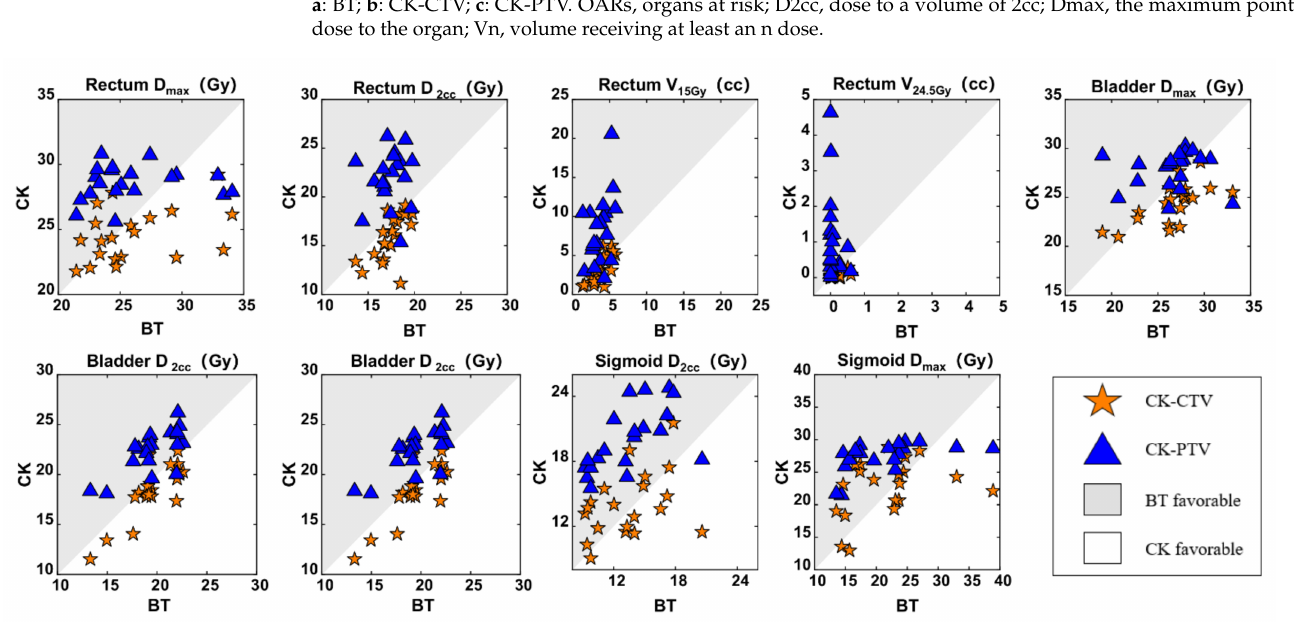
Figure 3. Comparisons of the BT, CK-CTV, and CK-PTV plans by the dosimetric parameters in relation to the OARs. For every patient, each parameter is associated with three values (from the BT plan, CK-CTV plan and CK-PTV plan). In each graph, for the parameter X, each patient will contribute a pair of symbols, i.e., a star and a triangle; the star is plotted by the coordinates X BT , X CK-CTV , while the triangle is plotted by X BT , X CK-PTV . A symbol falling in the gray area implies the parameter is favorable in the BT plan. A symbol falling in the white area implies the parameter is favorable in the CK